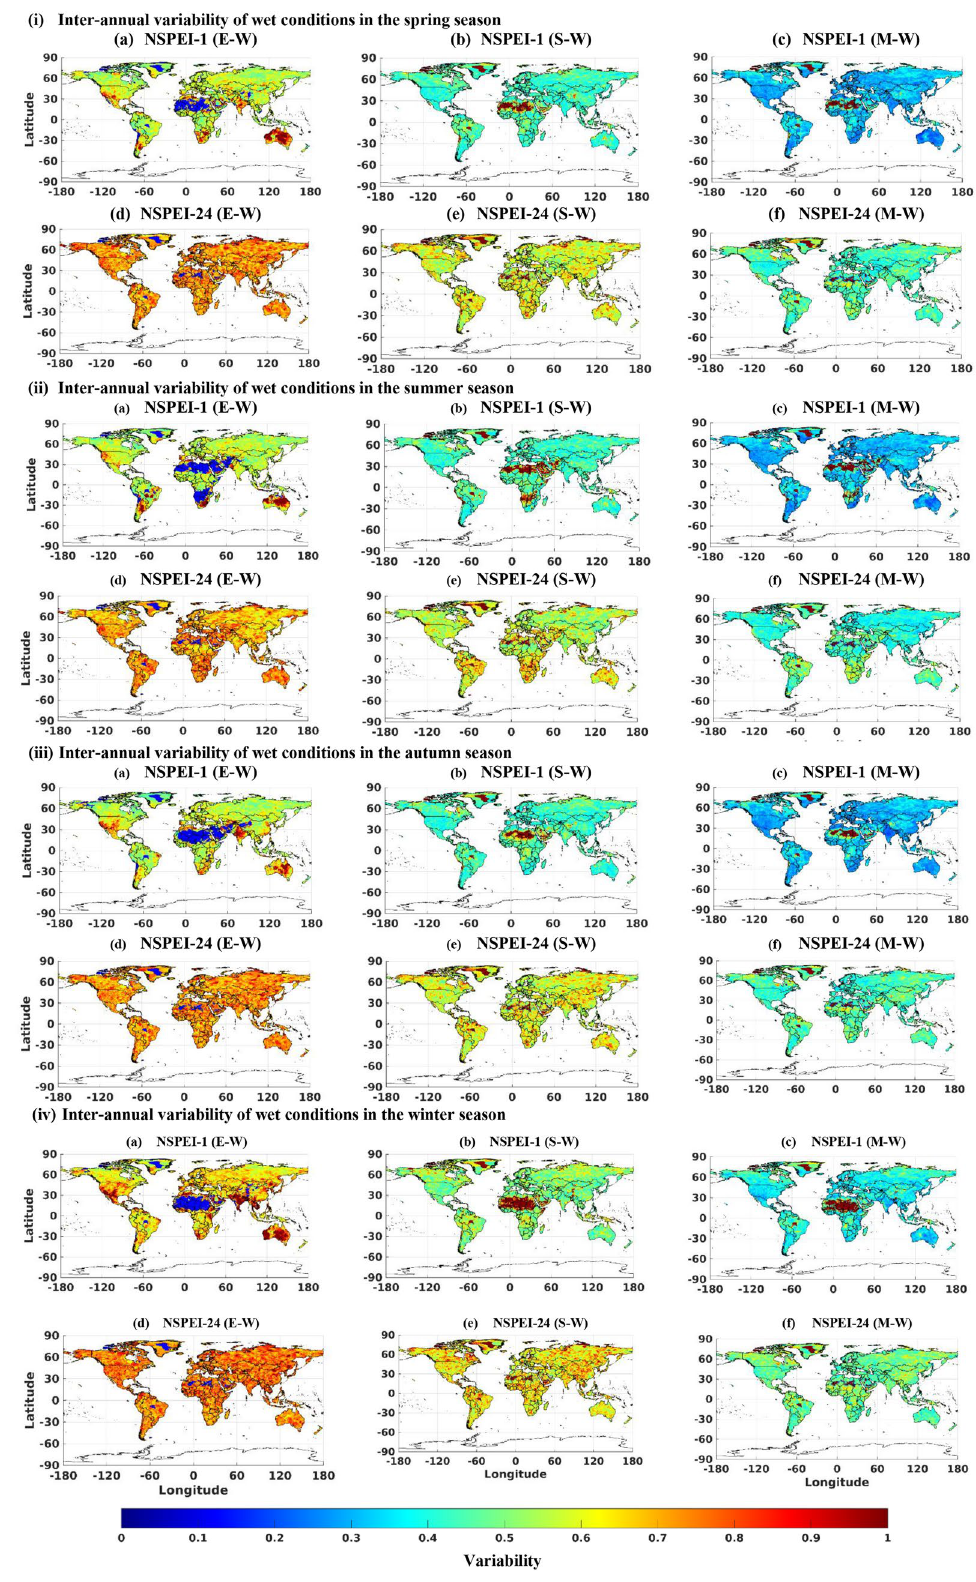
Figure 3. Inter-annual variability (SVI ME ) of wet conditions in different seasons ((i) spring, (ii) summer, (iii) autumn and (iv) winter) during the period 1901 to 2019. In the notation NSPEI- M , M indicates the accumulation period (AP) in months. Extreme, severe and moderate-intensity levels of wet conditions are denoted by E-W, S-W, M-W, respectively. *The maps were generated using MATLAB (version: